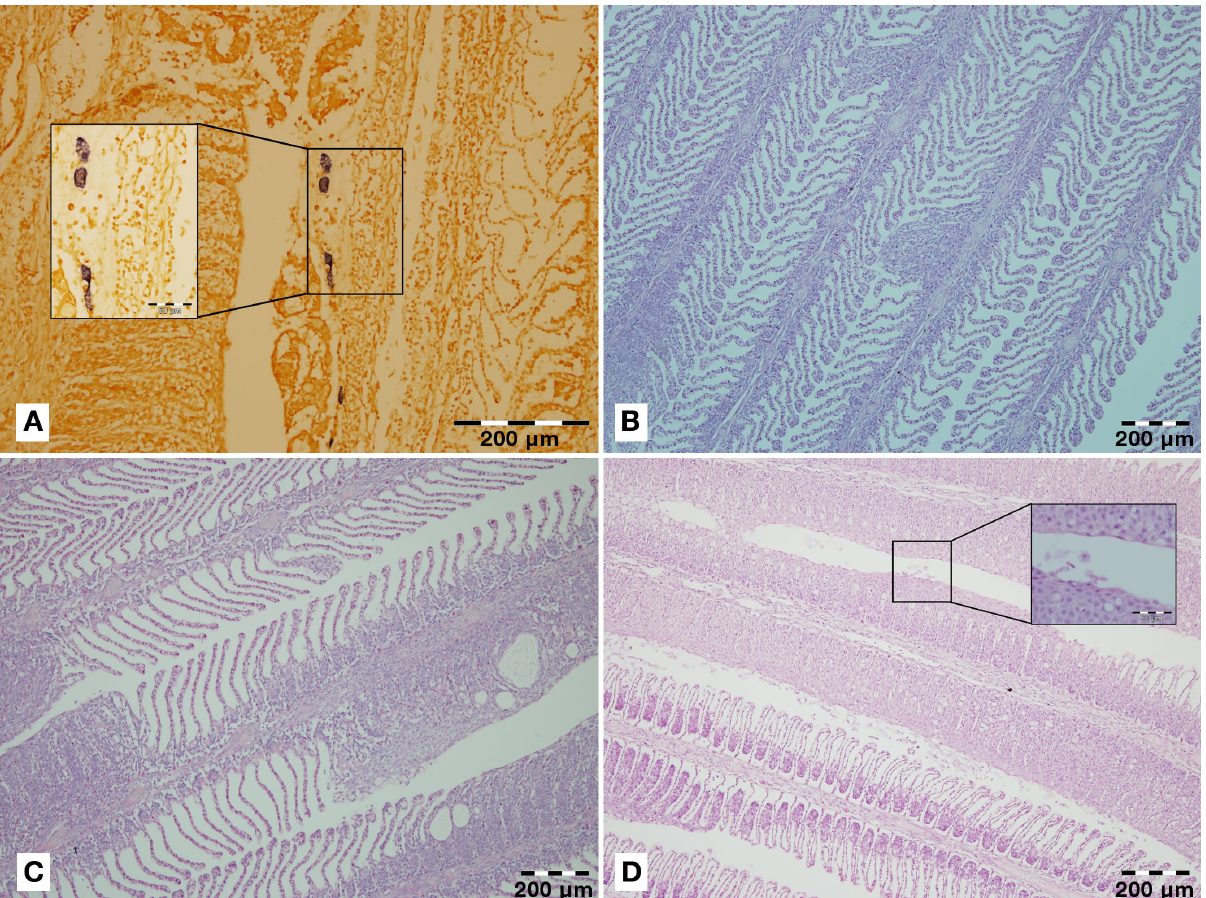
Fig. 5. (A) In situ hybridisation using species-specific oligonucleotide probes on Atlantic salmon gill sections examined from the study site. (Inset) Reactive dark cells indicate the presence of N. perurans . (B−D) Examples of the different levels of pathol- ogy observed in the gills of Atlantic salmon during this study: (B) a score of ‘1’ was assigned to a section where <10% pathol- ogy was observed; (C) a histological score of ‘2’ where there is between 10 and 50% pathology observed; (D) gills with >50% pathology showing complete loss of structure due to hyperplasia and fusion and (inset) amoeba present (histological score of